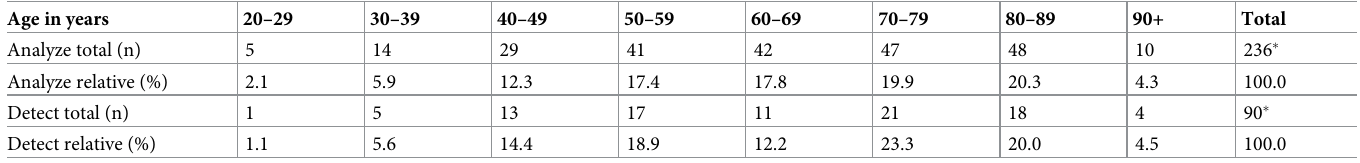
Table 1. Distribution of the scanned lesions in the different age classes. The total number of participants as well as the percentage in the respective algorithm-group is shown. Age in years